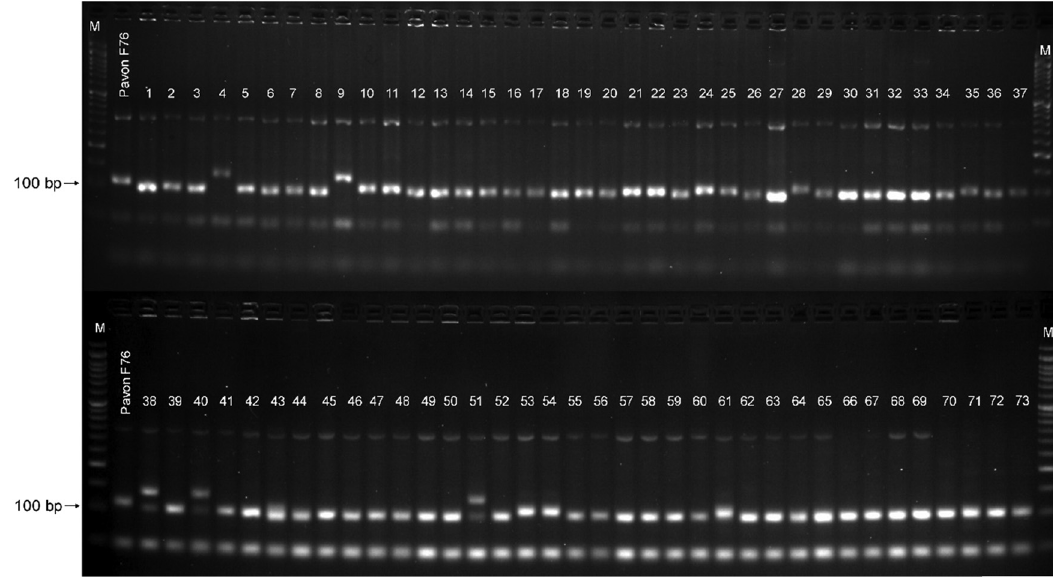
Figure 3: Electropherogram showing the presence of Xbarc80 marker linked to Lr46 gene in tested genotypes. M, FastGene 50 bp DNA Ladder ( NIPPON Genetics EUROPE GmbH ) ; 1 – 73 – wheat